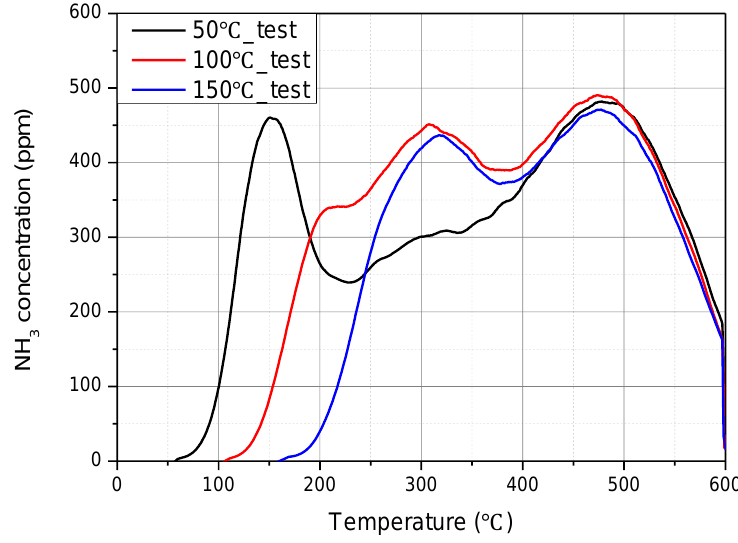
Figure 4. The effect of the NH 3 adsorption temperature on the NH 3 -TPD test (NH 3 supply concentration: 200 ppm, NH 3 supply time: 7500 s).